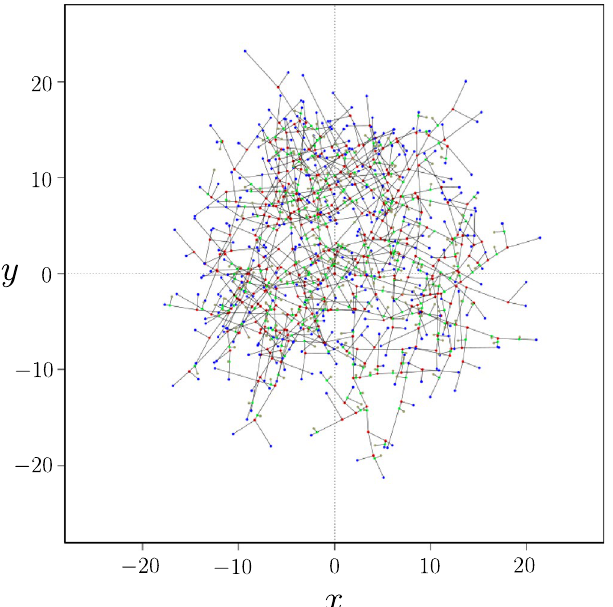
Figure 3. Final state (after nine generations) of simulated network for a set of standard parameters. Apical branching led to N V 1 = 384 apexes (shown in blue) and N V 3 = 383 vertices (in red). Lateral branching led to N V = 295 vertices (in green) and N V 3 ℓ